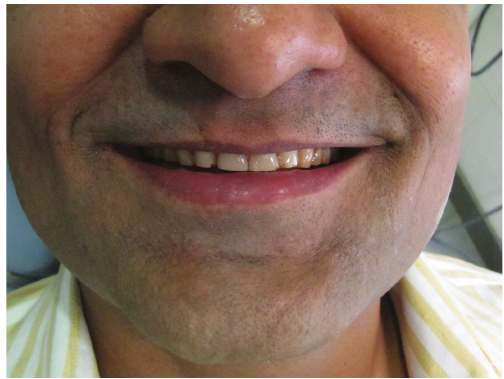
Figure 1: Preoperative extraoral view.